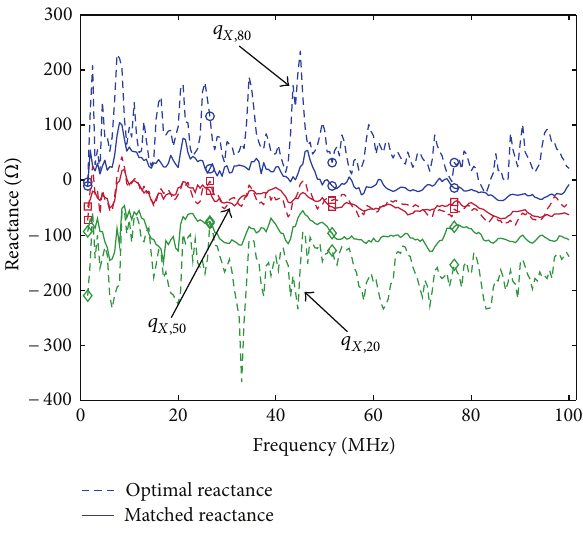
Figure 5: Quantiles of the resistive (a) and reactive (b) component of the output impedance. Three probability values are considered, that is, 10, 50 and 90%.